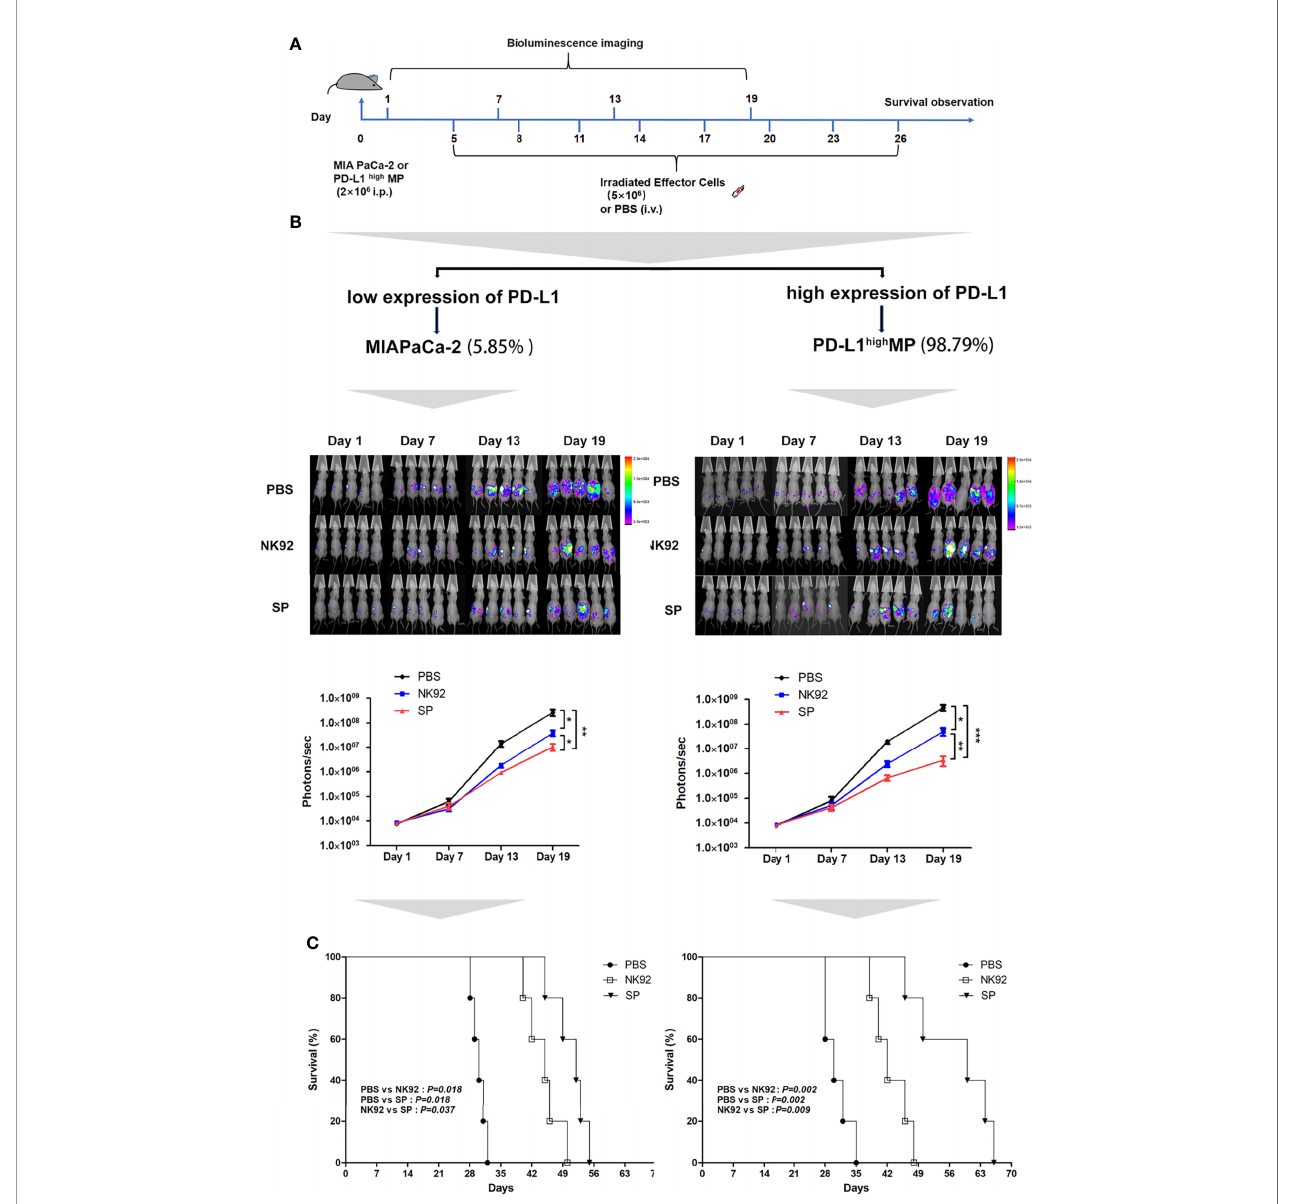
FIGURE 4 | In vivo anti-tumor ef fi ciency of SP cells in MIA PaCa-2 and PD-L1 high MP xenograft mouse model. (A) The construction of mouse model, and treatment protocol and observation. (B) Bioluminescence imaging was used to observe the photons of mouse abdominal cavity tumors re fl ecting the tumor size, to evaluate the therapeutic effects of SP and NK92 cells on abdominal tumor-bearing mice, as well as the statistical results of the photon levels. The left side shows the experimental results of the wild-type strain MIA PaCa-2 tumor-bearing mice, and the right side shows the experimental results of the PD-L1 high MP tumor-bearing mice stably transfected with the PD-L1 gene. Summary data are shown as the mean ± SEM, (*P < 0.05, **P < 0.01). (C) Overall survival was monitored and analyzed using Kaplan-Meier method. ***P <